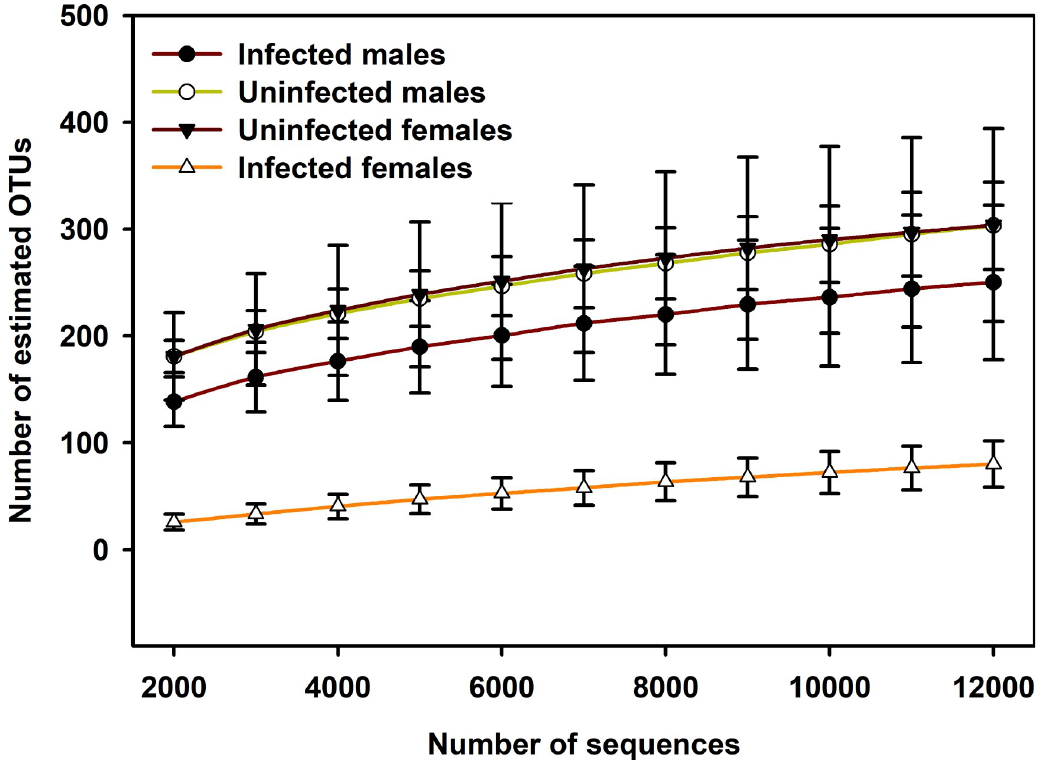
Fig 1. Rarefaction curves of adult mites infected and uninfected with Orientia tsutsugamushi . Number of observed OTUs in the 16S rRNA gene sequences of infected and uninfected adults for different rarefaction levels. Error bars are one SE of mean